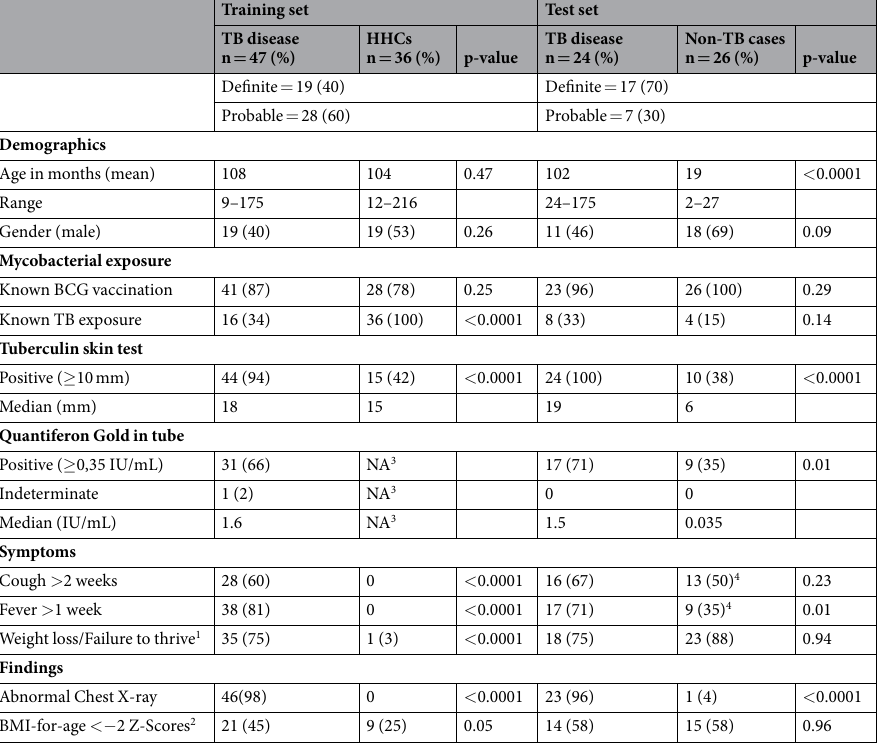
Table 1. Clinical characteristics of study subjects and distribution to training and test set. 1 Definition “Failure to thrive”: Loss of weight or no weight gain for 2 consecutive visits; downward crossing of 2 percentile lines on the weight-for-age growth chart, or weight that tracked consistently below the 3rd percentile in the weight-for- age growth chart. 2 Body Mass Index-for-age < 2 Z-scores defined as thinness according to WHO. 3 QFT not undertaken for asymptomatic controls. 4 No criteria for length of symptoms for the symptomatic non-TB cases in the present